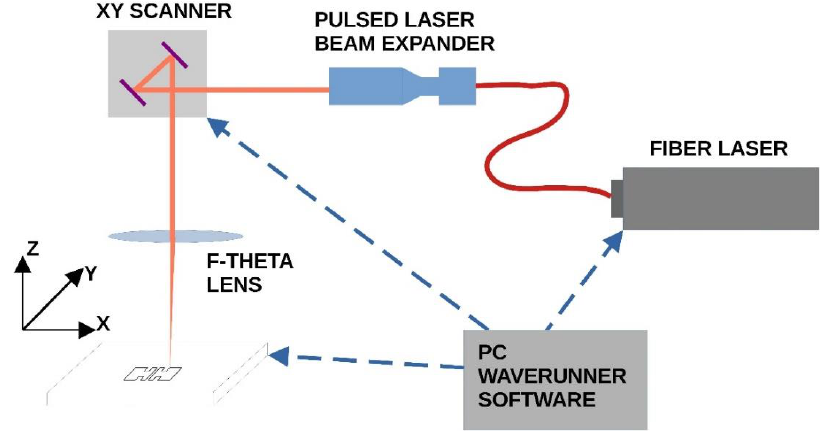
Figure 3. Diagram of the laser mask cutting system.